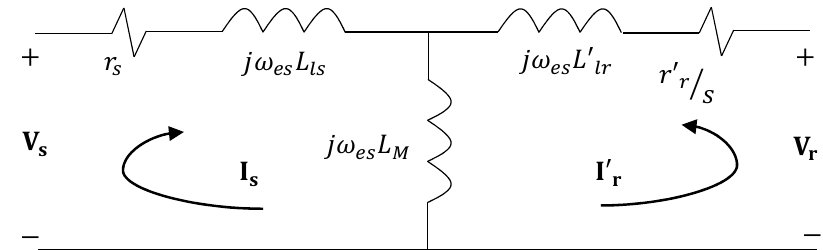
Figure 2. Equivalent circuit of the induction generator in steady-state seen from stator.